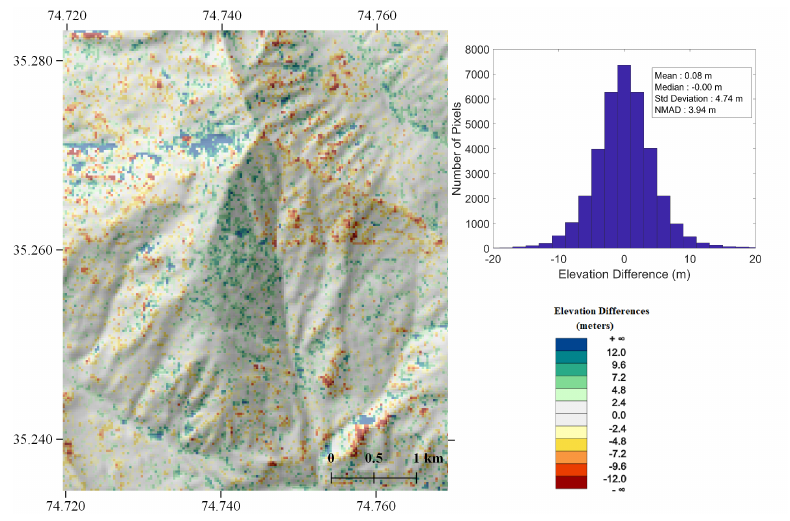
Figure 14. Elevation Differences between ALOS DEM and PlanetScope DEM over stable terrain in Nanga Parbat